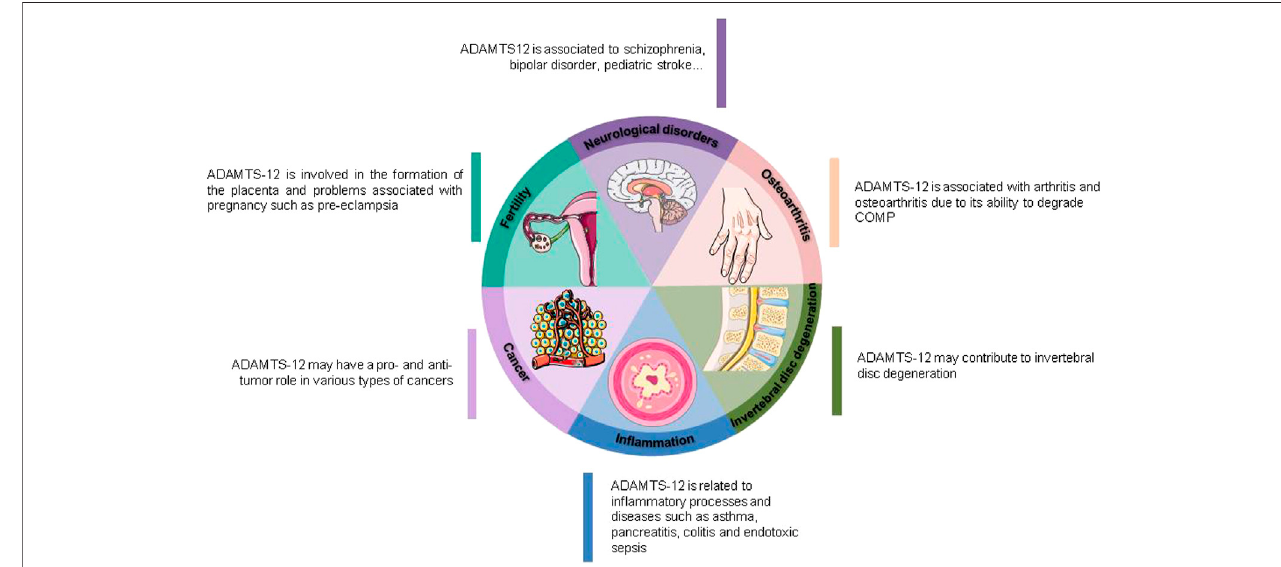
FIGURE 2 | ADAMTS-12 biological